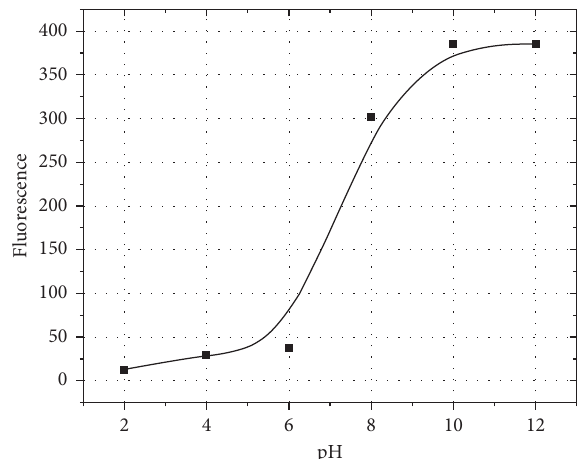
− A)/(A − A max min )] for cou-